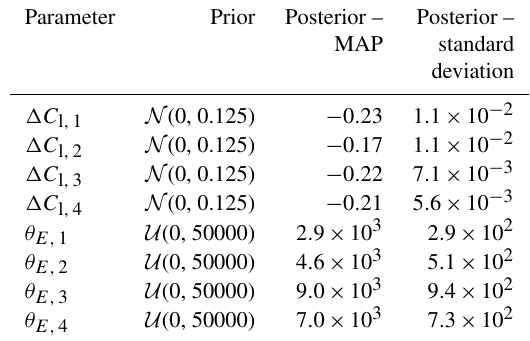
Table 2. Summary of prior and posterior distribution for DANAERO calibration with 200 measurements. (cid:49)C l is dimension- less, and θ E has dimensions N 2 m − 2